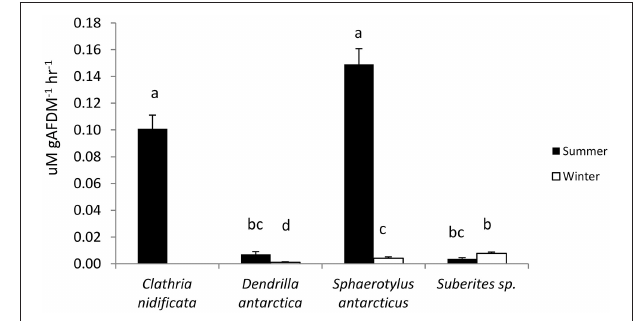
FIGURE 3 | Ammonia production by sponges in summer and winter. Values of ammonia production with the same letter are not significantly different (Tukey tests, P < 0.05 ).